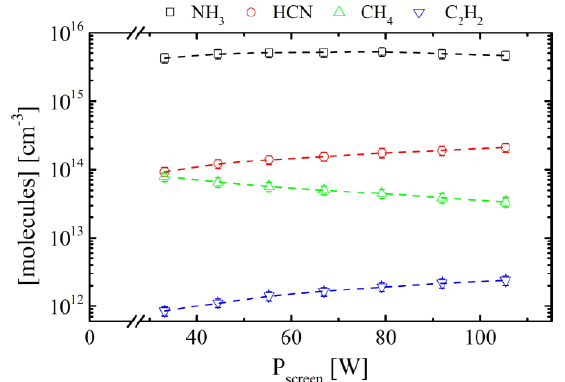
Figure 32. The concentrations of NH 3 , CH 4 , HCN and C 2 H 2 depending on the power of the screen plasma ( p = 3 mbar, 10 sccm H 2 + 10 sccm N 2 + 0.2 sccm CH 4 ) [63], Reproduced from [63], with the permission of AIP Publishing.